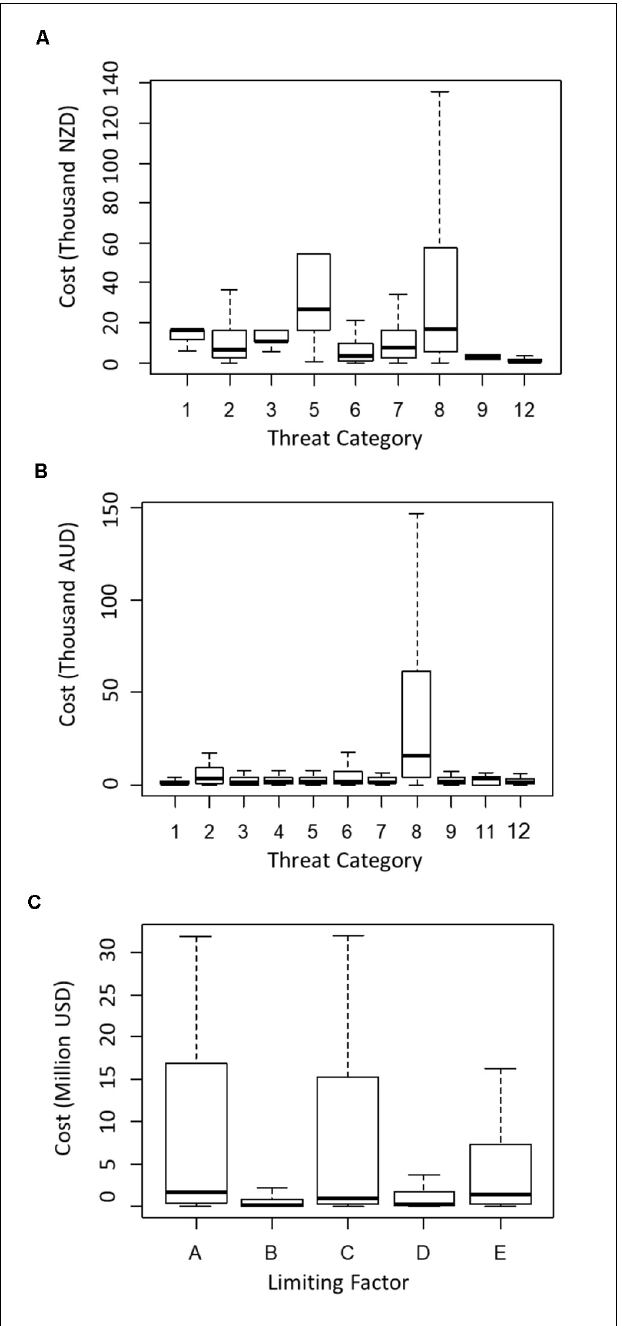
FIGURE 1 | Costs of conservation actions addressing each threat category, for (A) New Zealand; (B) New South Wales; and (C) United States. Threat categories (“Limiting Factors”) for United States. Threat Categories for New Zealand and New South Wales are as follows: 1 = development, 2 = agriculture, 3 = energy, 4 = transport, 5 = resource use, 6 = disturbance, 7 = modification, 8 = invasive species, 9 = pollution, 10 = geological, 11 = climate change, 12 = other (see Table 1A and Supplementary Table S1 for details). Limiting Factors for United States are as follows: A = habitat destruction or modification, B = overexploitation, C = disease or predation, D = inadequacy of regulations, E = other natural or anthropogenic factors (see Supplementary Table S2 and US Fish and Wildlife Service [USFWS], 2012 for